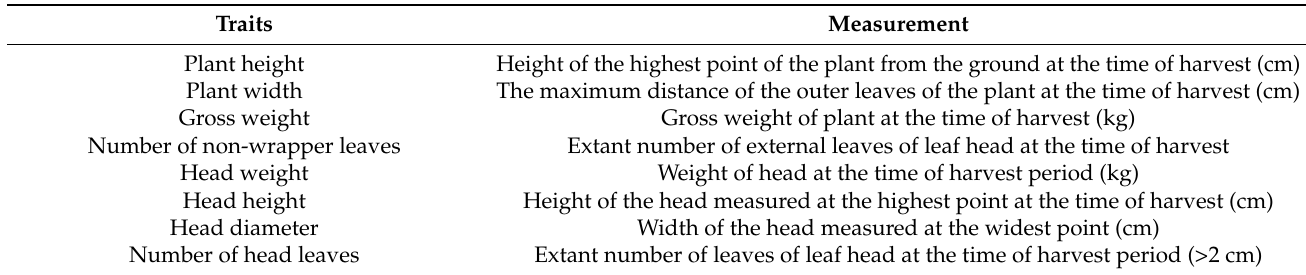
Table 1. Summary of the agronomic traits and their measurements. Traits Measurement Plant height Height of the highest point of the plant from the ground at the time of harvest